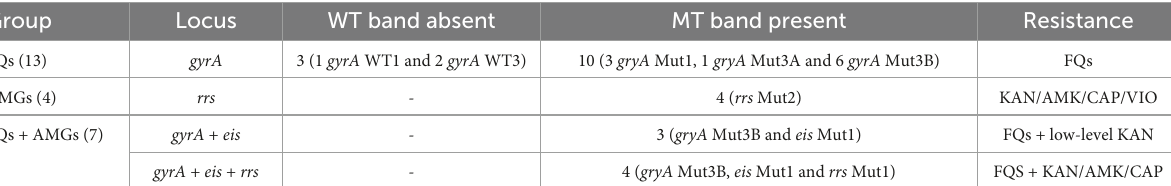
TABLE 4 Observed MTBDR sl assay band